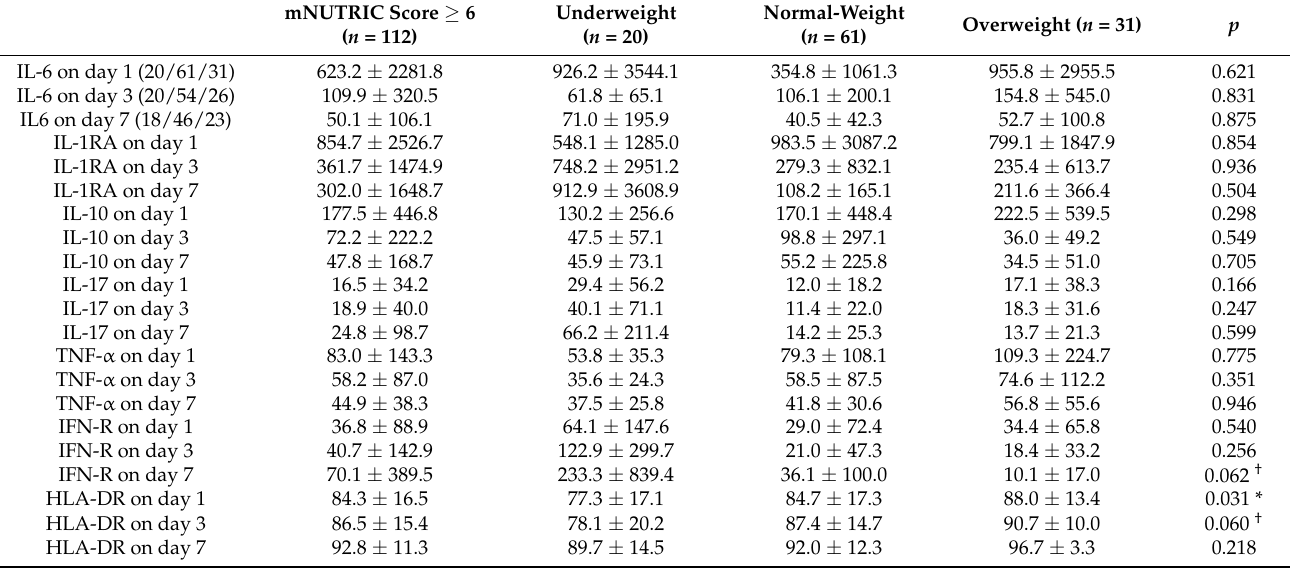
Table 7. Biomarkers of patients with sepsis who had high modified NUTRIC